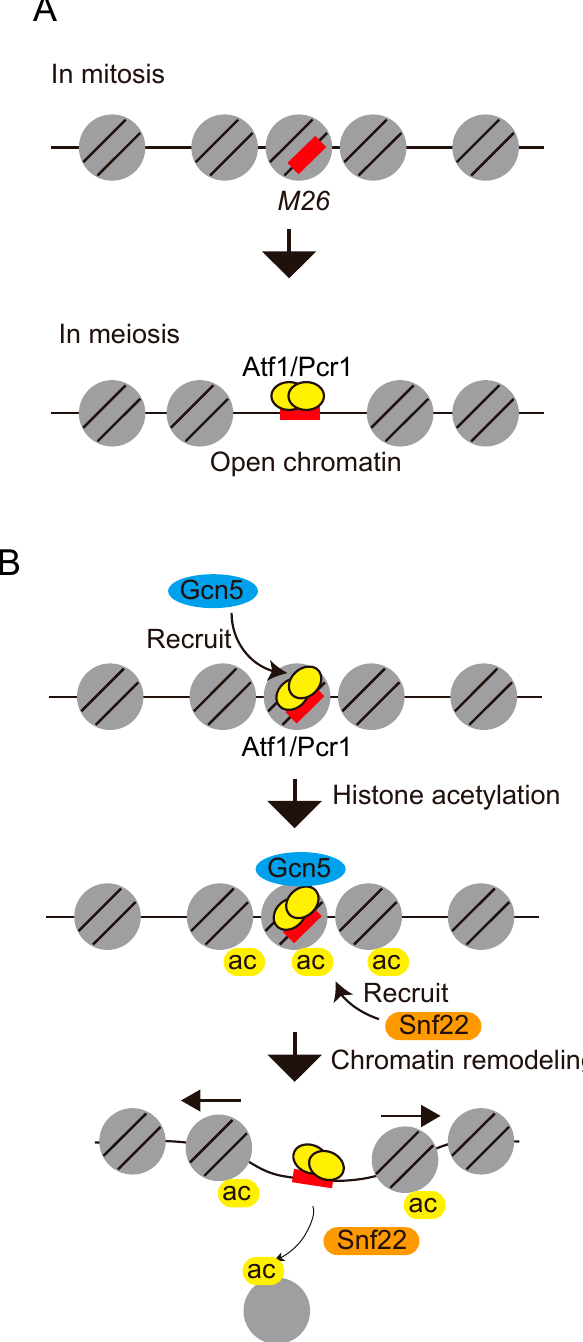
Figure 3. A model of meiotic recombination at ade6-M26 by histone acetylation-mediated chromatin remodeling. ( A ) During meiosis, the state of the chromatin at the M26 mutation site changes to open configuration. This chromatin alteration is dependent on Atf1/Pcr1 and CRE-like heptanucleotide sequence, 5 ′ -ATGACGT-3 ′ . The binding of Atf1 to M26 site is enhanced in meiosis. ( B ) Histones around M26 are acetylated by Gcn5 histone acetyl transferase and probably other histone acetyl transferases, which are recruited to the M26 site via Atf1/Pcr1. Acetylated histones are recognized by ATP-dependent chromatin remodelers including Snf22. DSB machinery is recruited to the open chromatin region created around M26 , thereby activating meiotic